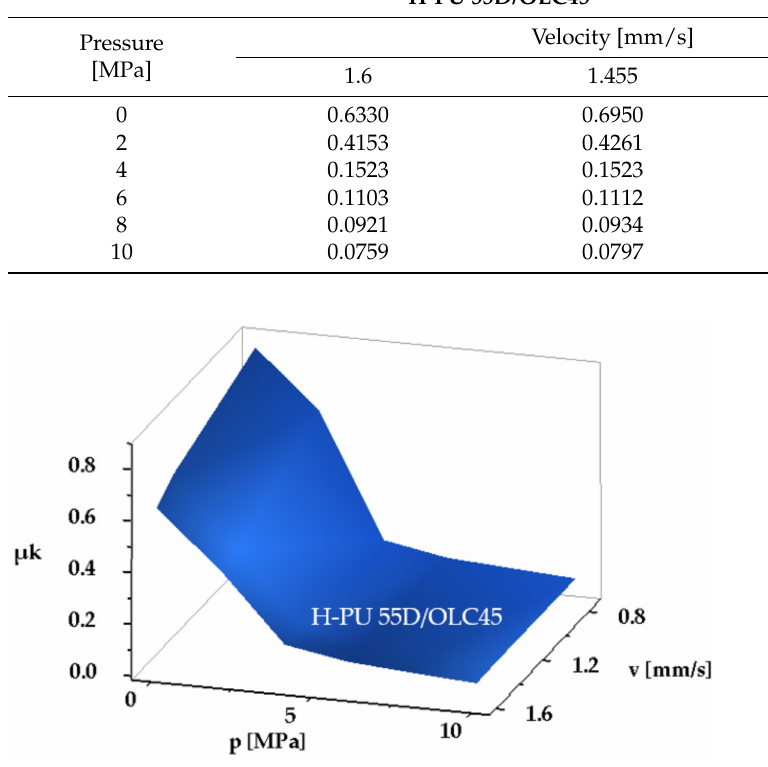
Figure 10. Dependency of the minimum kinematic friction coefficient on contact pressure and velocity for the material pair H-PU